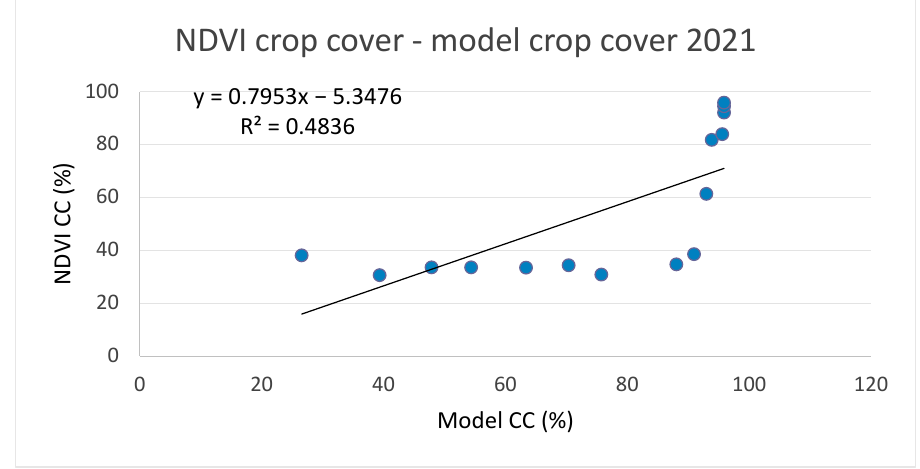
Figure 7. Comparison between NDVI canopy cover and modeled canopy cover for winter wheat in 2021.